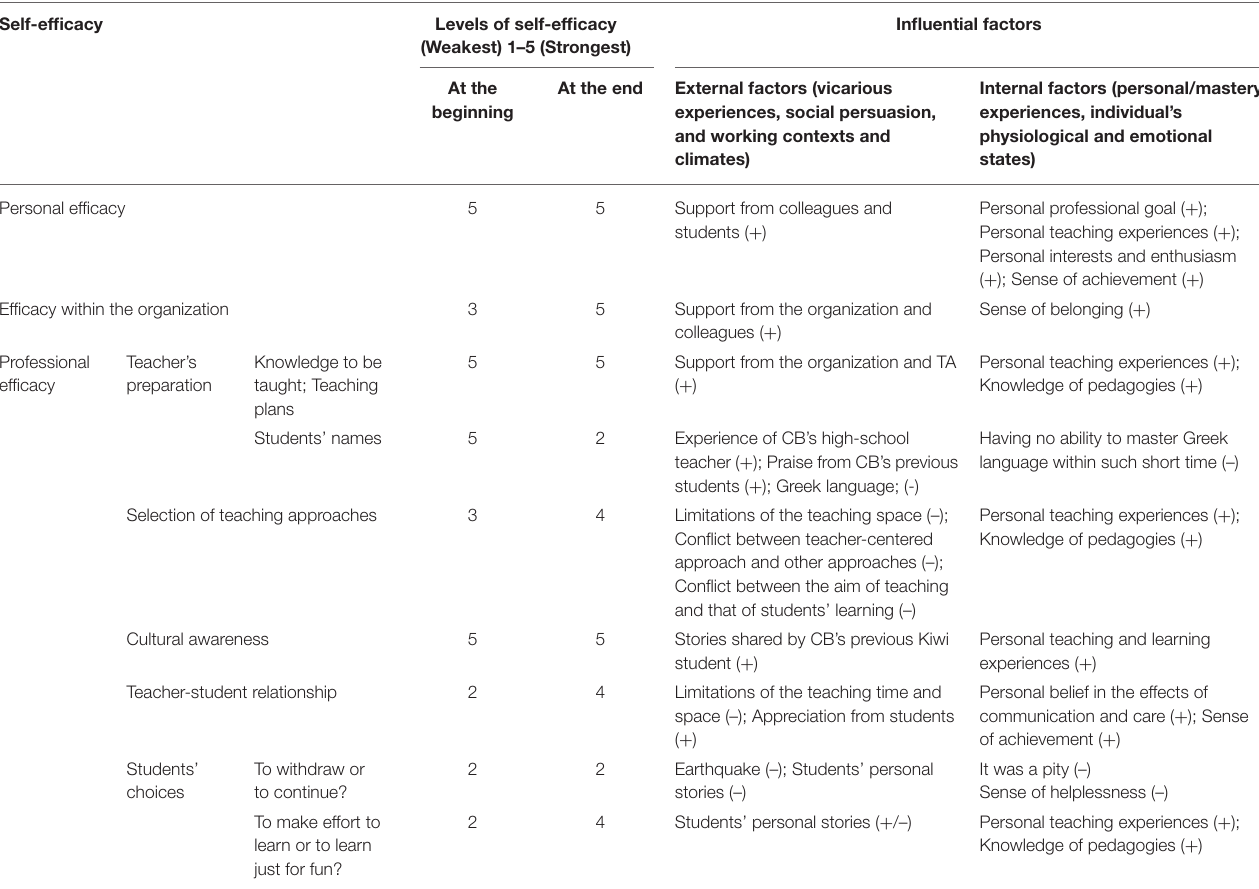
TABLE 3 | Summary of findings.